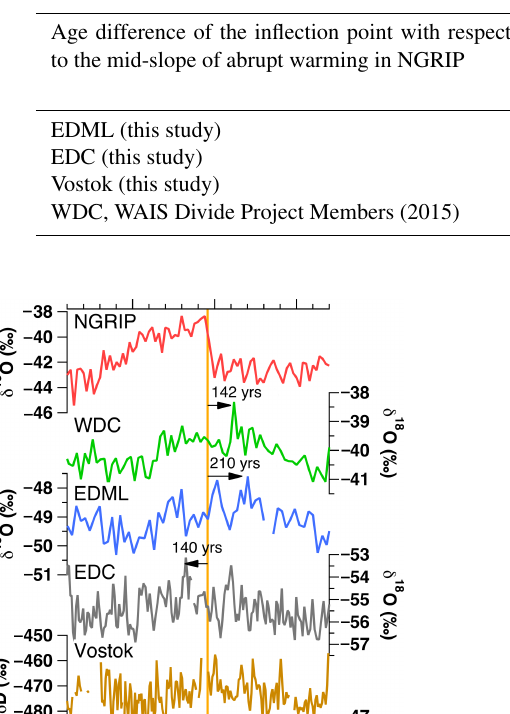
Table 2. Phasing between NGRIP GS–GIS transition and AIM for different Antarctic ice cores over DO-AIM 10.